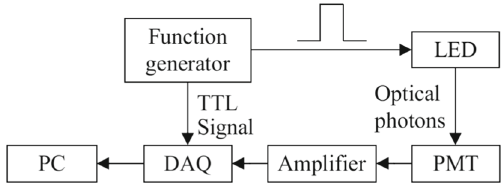
Fig. 2 Trigger logics for the PMT single-PE response measurements